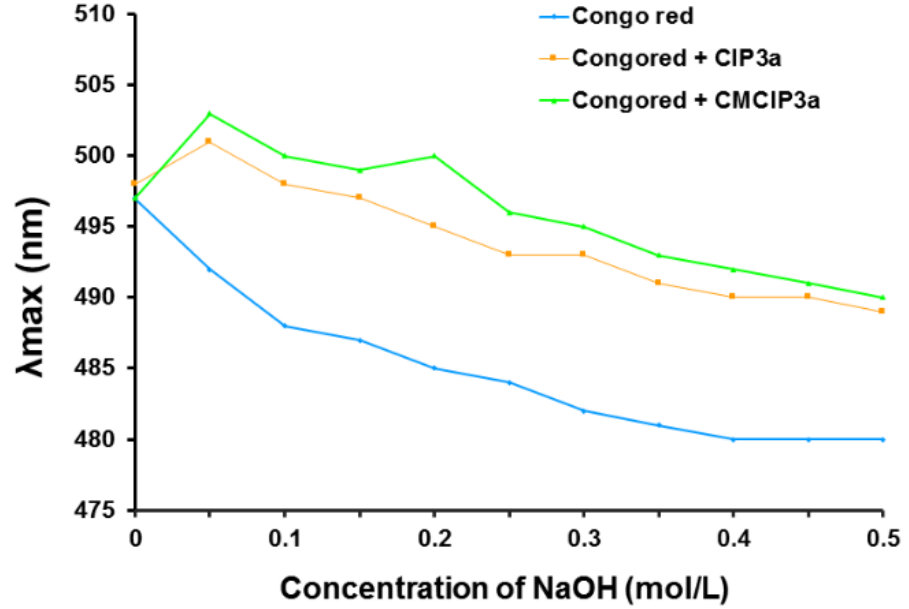
Figure 6. Effect of polysaccharide on the absorbance of Congo